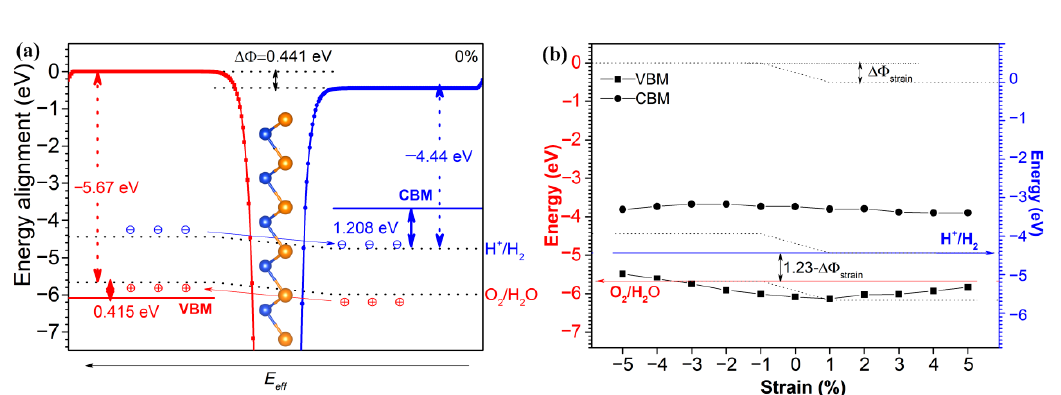
Figure 5. ( a ) The band alignment of 2D polar monolayer SiTe; ( b ) the Band alignment as a function of strain engineering.